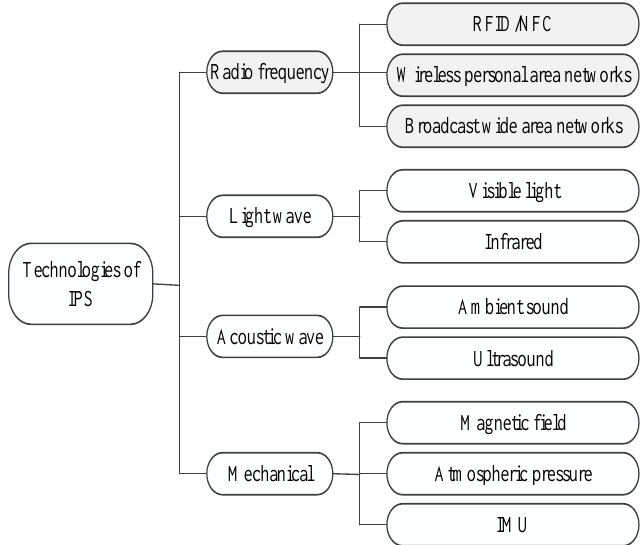
Figure 1. Categorization of major technologies used in indoor positioning system (IPS)